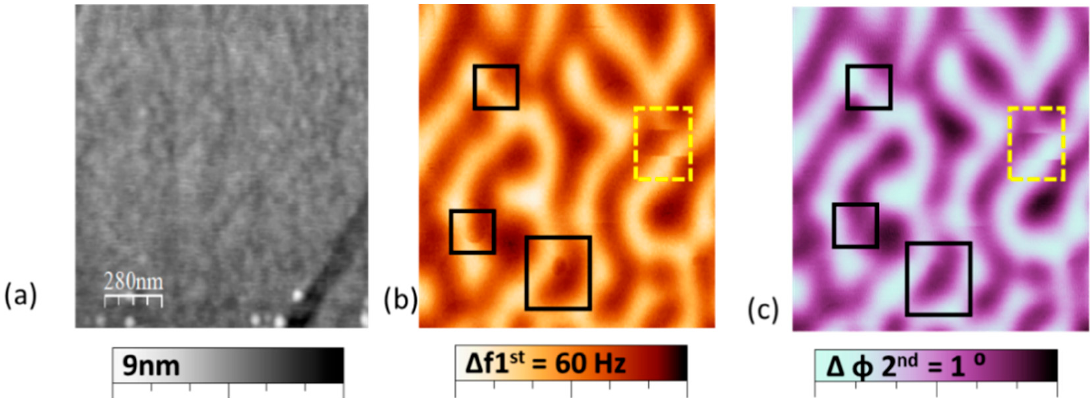
Figure 4. ( a ) Topography of the sample (CoCr thin film), ( b ) frequency shift of the first mode during the second scan (MFM signal), ( c ) phase of the second mode, second scan. The black squares indicate dissipation-related features in the magnetic image (only present in the f 1 image) whereas the yellow dotted line remarks a change in the magnetic configuration of the sample due to the tip stray field. Images size: 1.4 µ m × 1.4 µ m. A 1 = 20 nm. A 2 = 0.75 nm. Z lift distance = 30